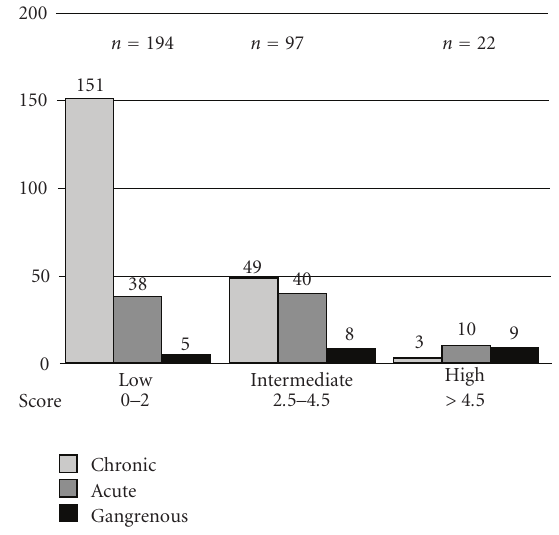
Figure 1: Distribution of cholecystitis according to probability group in the derivation population.